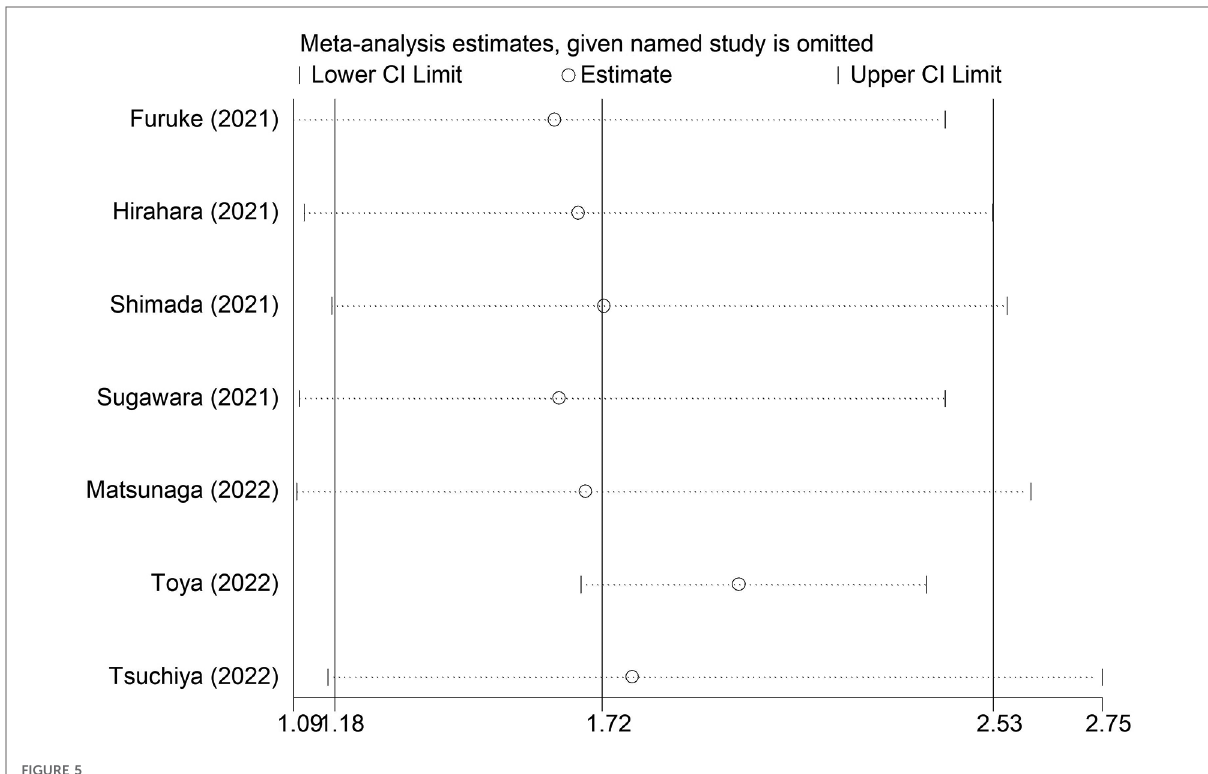
FIGURE 5 Begg ’ s funnel